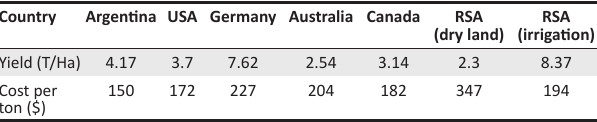
TABLE 3: International wheat production cost for the year